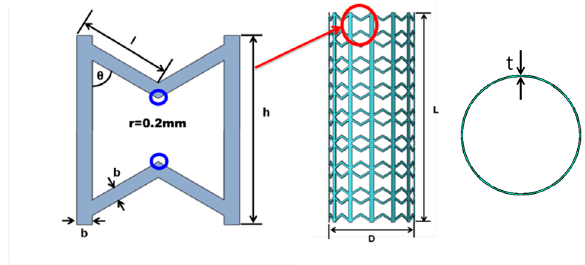
Figure 2. Unit cell and structure of the SMP stent.